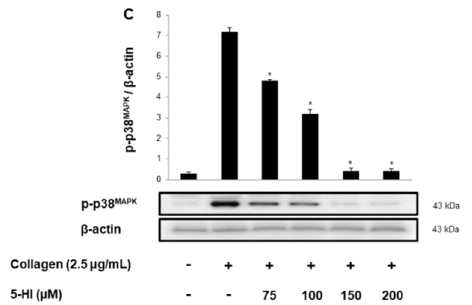
Figure 3. Effect of 5-HI on TXA 2 production and cPLA 2 and p38 MAPK phosphorylation. ( A ) 5-HI’s effect on collagen-induced TXA 2 generation. ( B ) 5-HI’s effect on collagen-induced cPLA 2 phosphorylation. ( C ) 5-HI’s effect on collagen-induced p38 MAPK phosphorylation. All experiments were performed as described in “Materials and Methods” section. The data are expressed as the